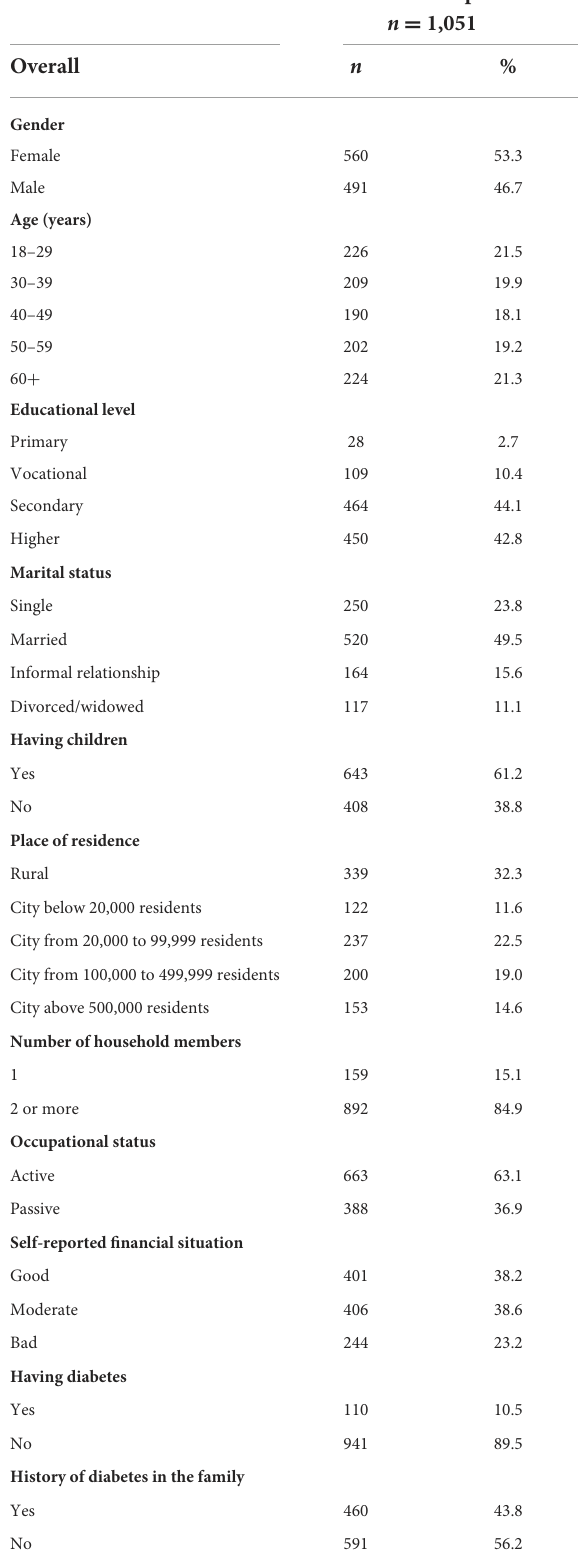
TABLE 1 Characteristics of the study population ( n =